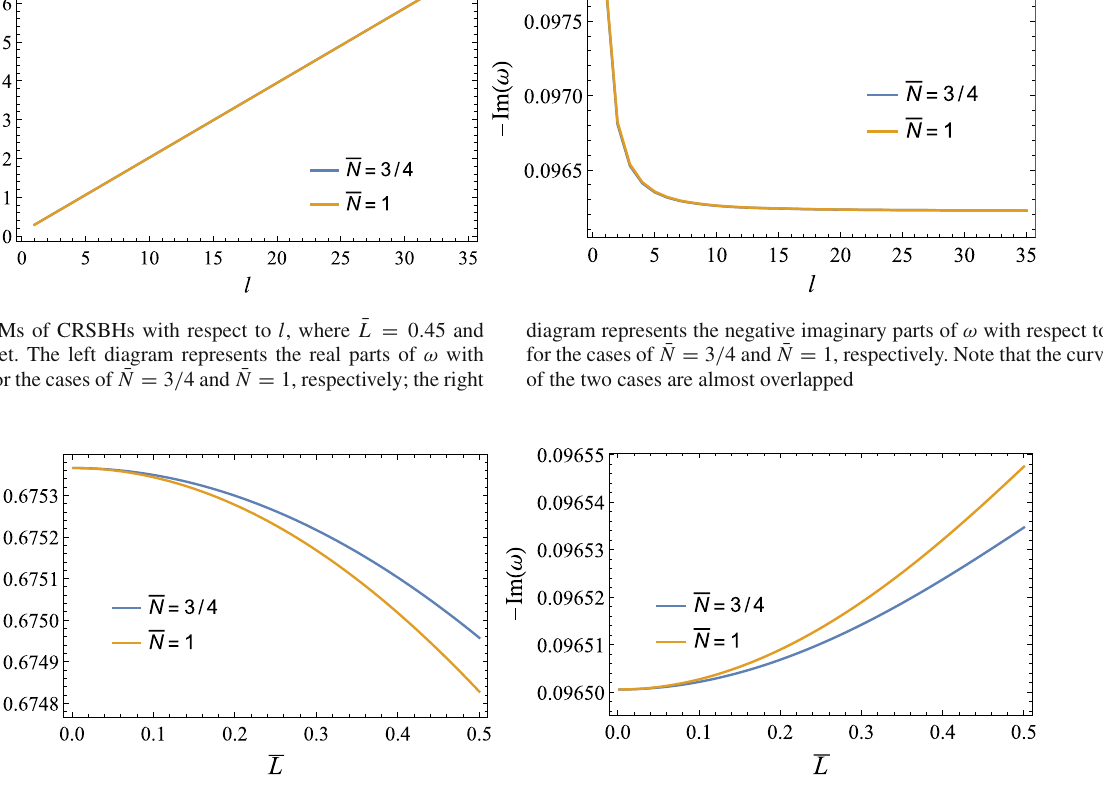
represents the negative imaginary parts of ω with respect to ¯ L for the cases of ¯ N = 3 / 4 and ¯ N = 1,